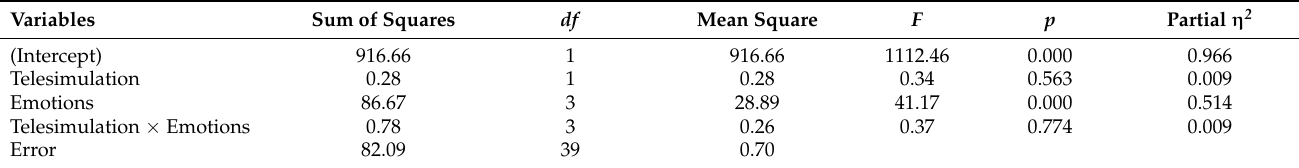
Table 3. ANOVA results of emotions during the task.